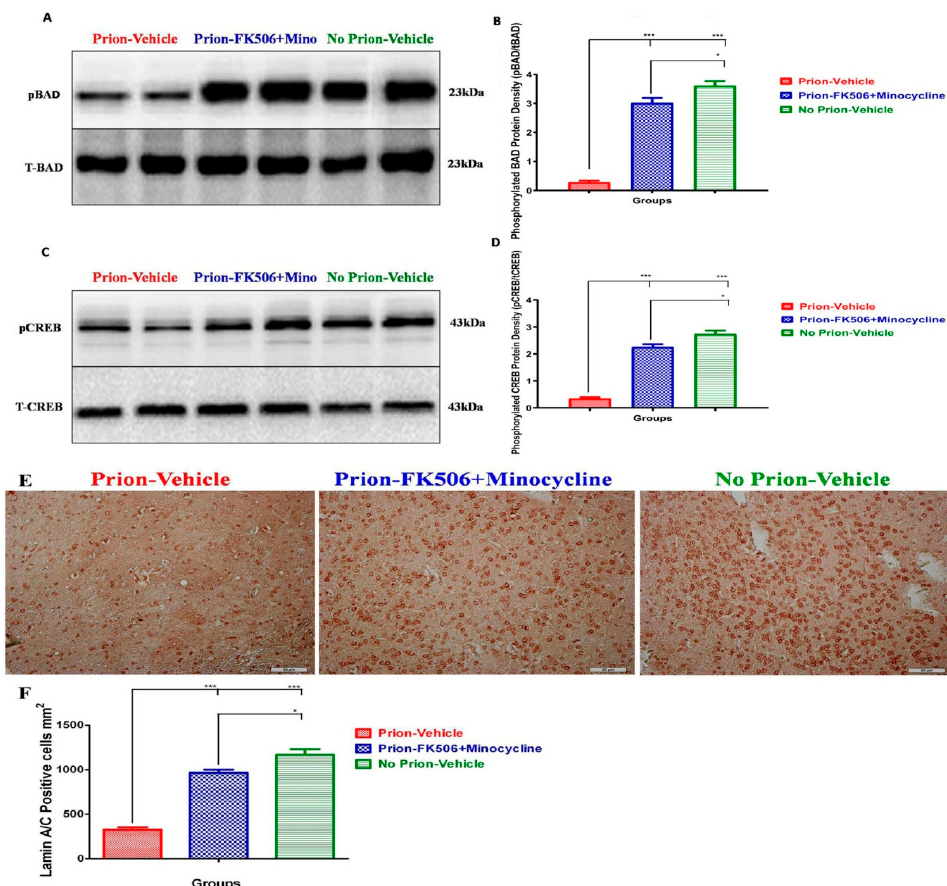
Figure 9. FK506+minocycline treatment increases cognition and survival via CREB and BAD phosphorylation. ( A ) Representative western blot panel of two animals each per group for total BAD and phosphorylated BAD levels. ( B ) Graphical presentation of expression level of phosphorylated BAD in different groups based on 5 animals data per group. Values were normalized using total BAD as loading control. The data was analyzed by using a one way ANOVA test followed by post hoc test tukey’s multiple comparison. ( P ≤ 0.05 = * and P < 0.0001 = ***). ( C ) Representative western blot panel of two animals from each group for total CREB and phosphorylated CREB levels. ( D ) Graph showing protein expression level of phosphorylated CREB in different groups based on 5 animals data per group. Values were normalized using total CREB as loading control. The data was analyzed using a one way ANOVA test followed by post hoc test tukey’s multiple comparison. ( P ≤ 0.05 = * and P < 0.0001 = ***). ( E ) Representative pictures of immunohistochemical analysis for the expression of LMN A/C protein in different groups (scale bar-50 µ m). ( F ) Data showing the protein expression levels of LMN A/C for apoptosis analysis in different experimental groups based on 5 animals each per group. The data was analyzed by using a one way ANOVA test followed by post hoc test tukey’s multiple comparison. ( P ≤ 0.05 = * and P < 0.0001 = ***).